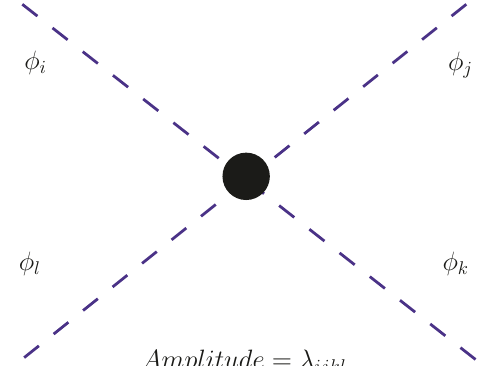
Figure 14. Scalar four-point interactions: amplitude is the e(cid:11)ective scalar quartic coupling (cid:21) ijkl . The [ ] represents the e(cid:11)ective four-point scalar vertex. (cid:15) the dimension-6 operators. The added contributions are directly from (cid:30) 6 operators, and also from the (cid:30) 4 D 2 operators through the rede(cid:12)nition of the scalar (cid:12)elds.